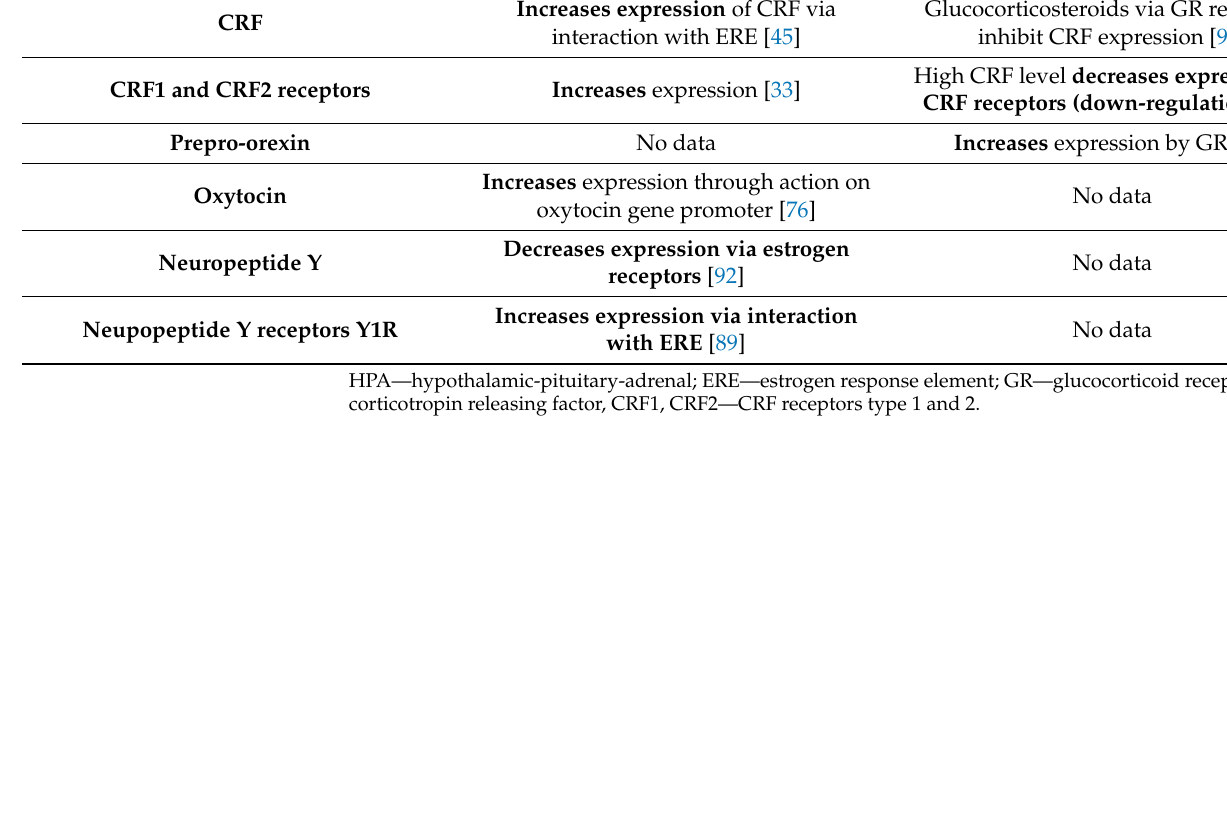
Table 1. Influence of estrogens and HPA axis on the expression of selected hypothalamic peptides. Hypothalamic Peptide Estrogen Influence HPA Axis Influence Increases expression of CRF via interaction with ERE